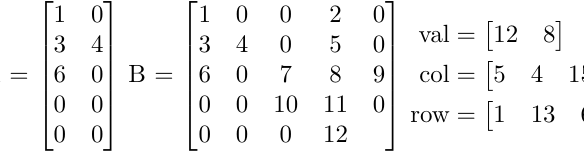
Figure 4. Hybrid ELL/COO (HYB) representation of matrix A